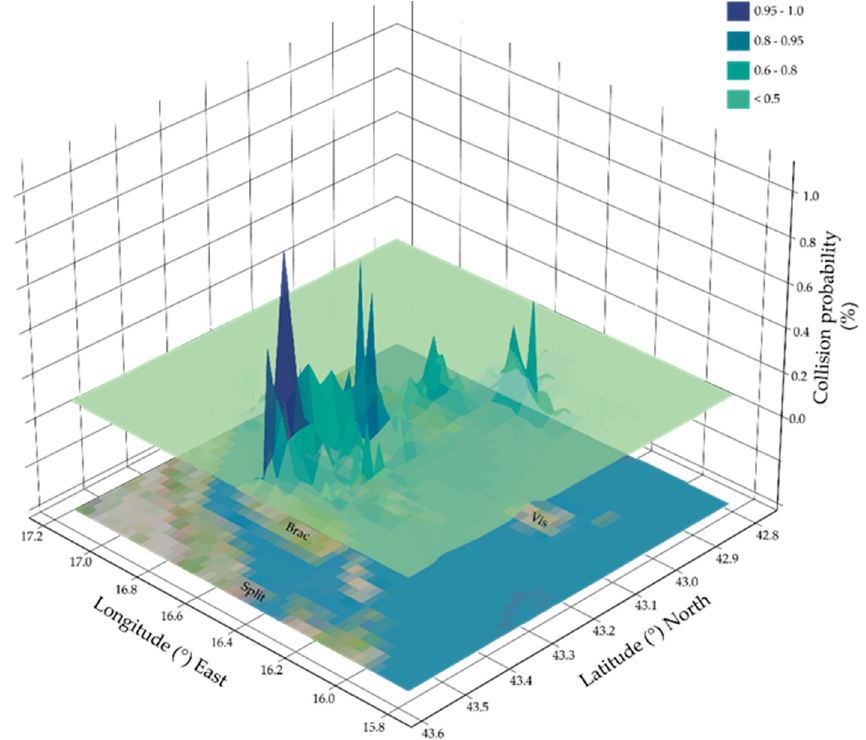
Figure 11. Collision probability as result of MC.